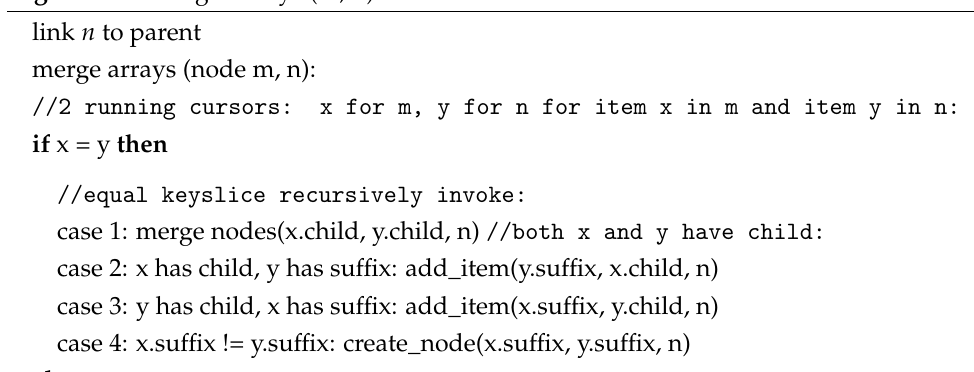
Algorithm 2 Merge Arrays (m,